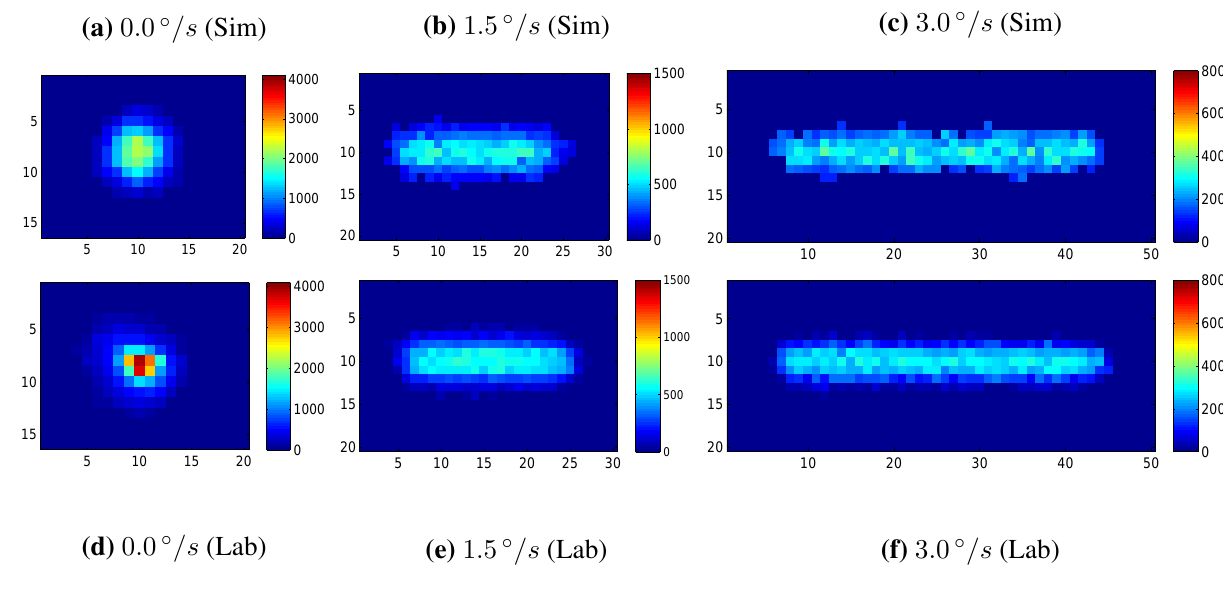
Figure 8. Simulated and lab-based images of a m ≈ 3 . 5 star at varying slew rates.